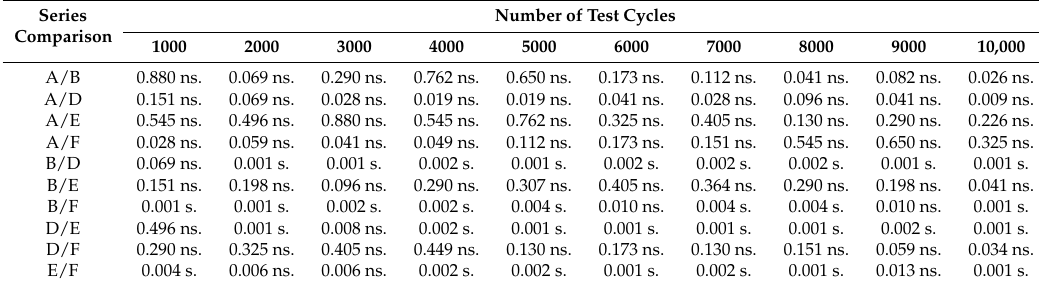
Table 5. Statistical test results: p -Values of the U -test with Bonferroni correction of the averaged pull-off forces for series comparison, taking the number of load-change cycles into account; s.—significant, ns.—not significant.